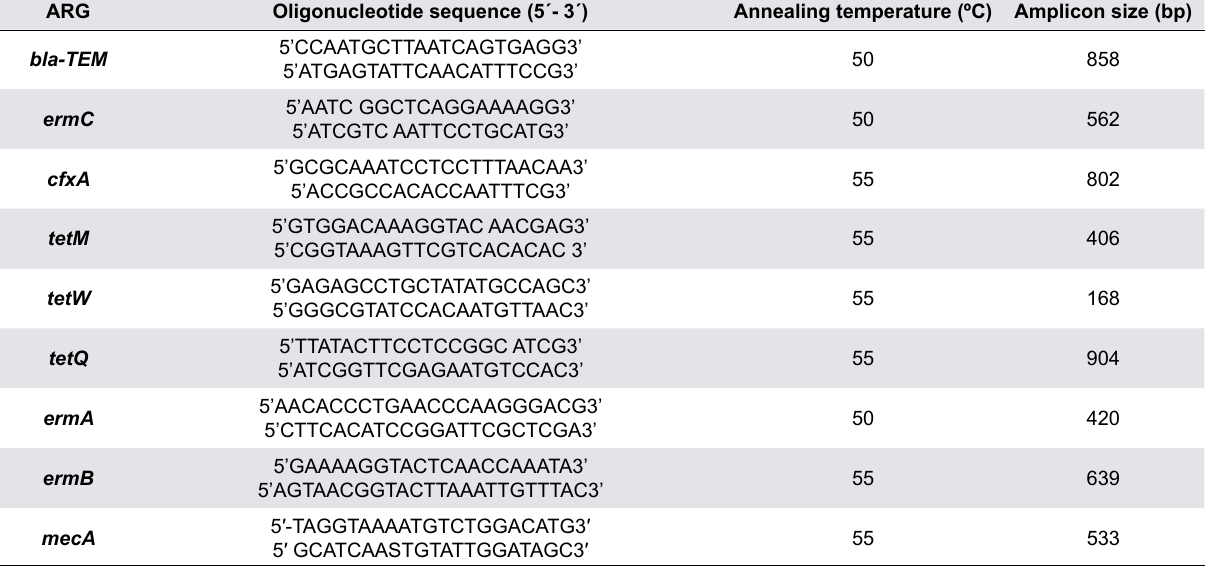
Table 1- Oligonucleotides employed to detect the nine antimicrobial resistance genes (ARGs)